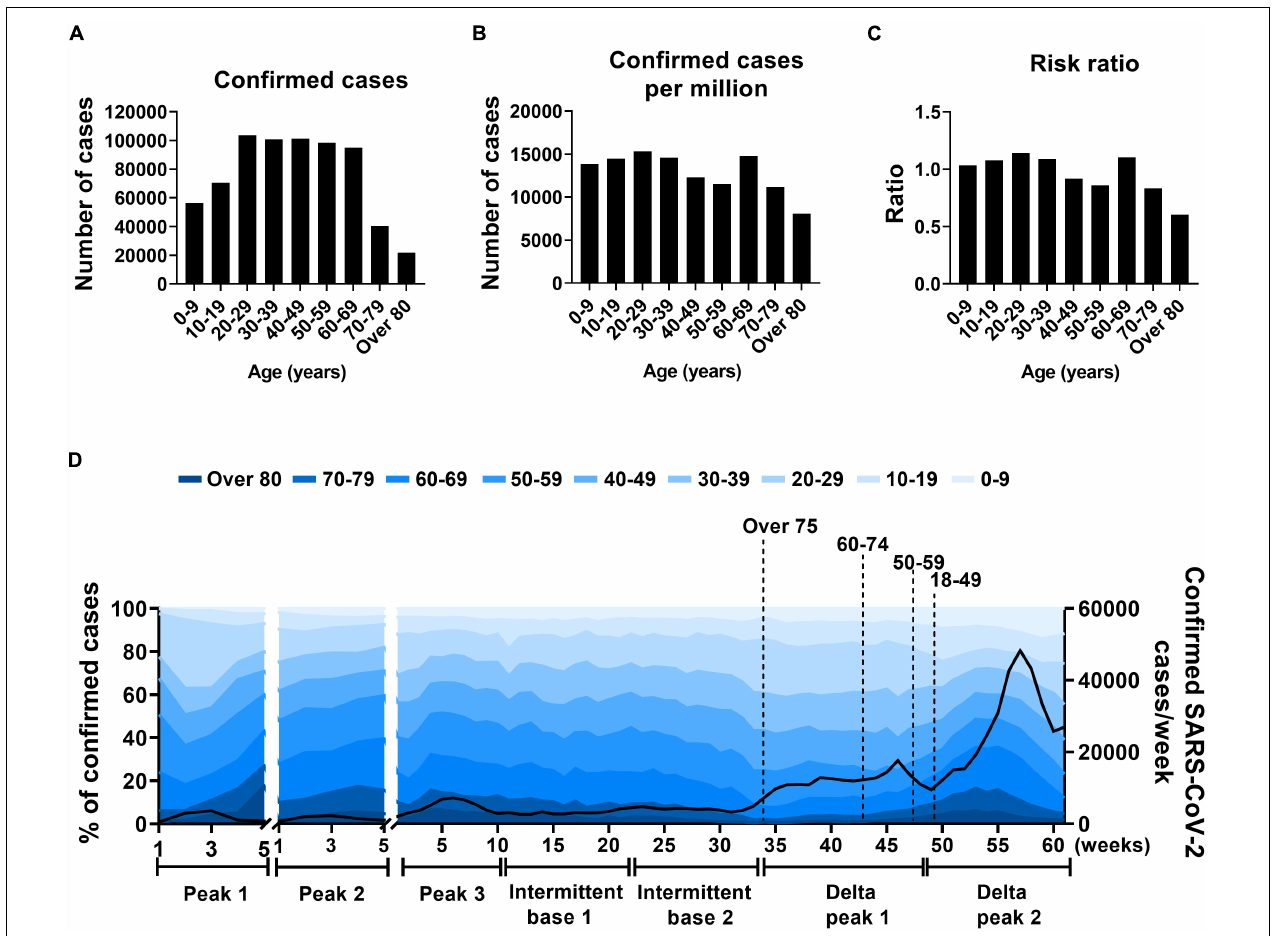
FIGURE 5 | Age distribution in SARS-CoV-2 infection. (A–C) Total confirmed cases of SARS-CoV-2, confirmed SARS-CoV-2 cases per million populations, and risk ratios by 10-year age group. (D) Proportions of SARS-CoV-2 cases by total confirmed cases. Solid line indicates weekly confirmed cases, x-axis indicates number of weeks of specified periods, and dotted lines indicate when vaccinations reached 80% for each age